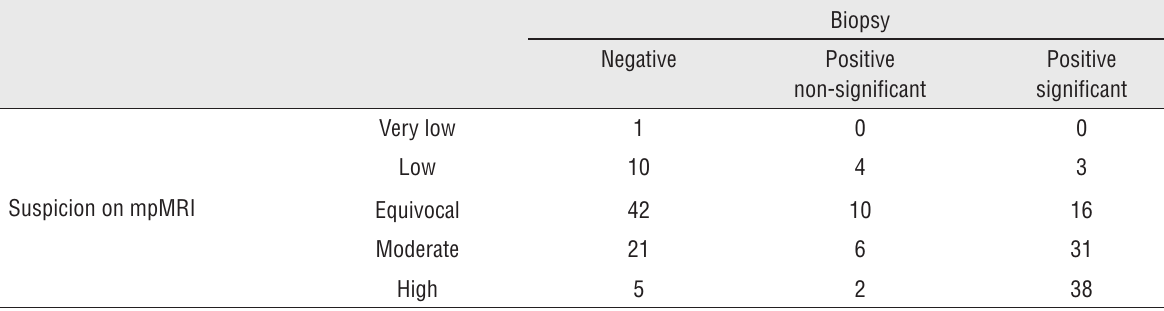
Table 2 - Suspicion level on mpMRI and biopsy results.